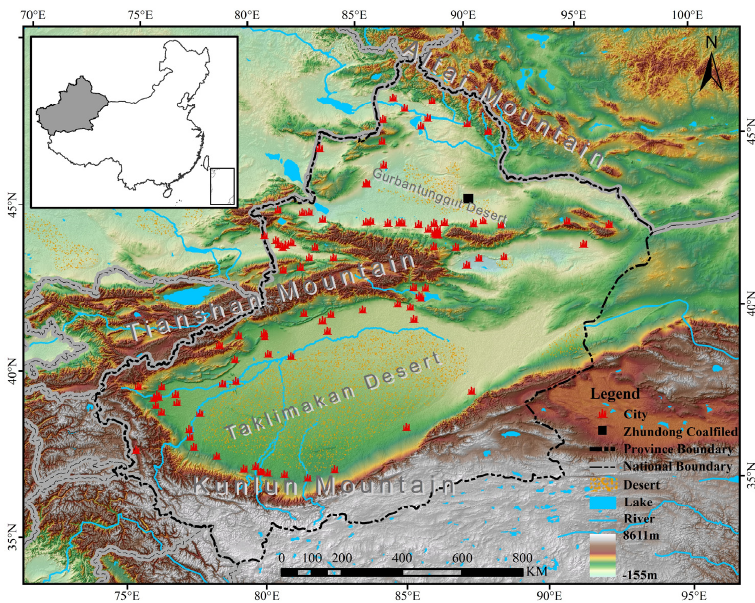
Figure 1. Study area.